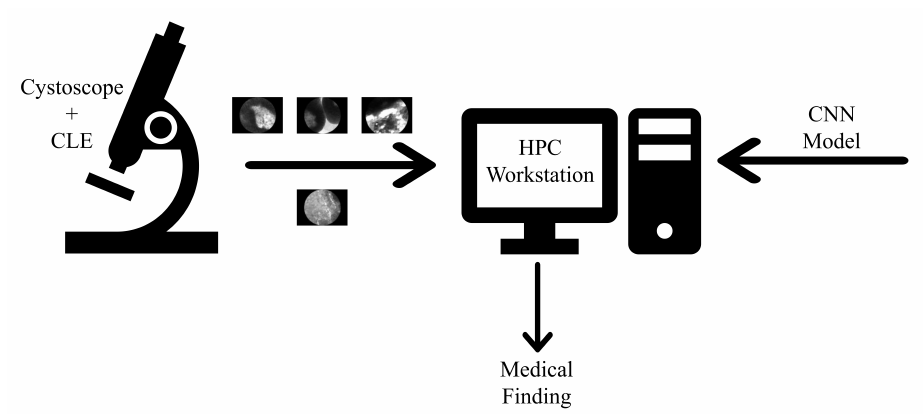
Figure 1. Dataflow diagram of Convolutional Neural Network-based (CNN) utilization in urinary bladder cancer